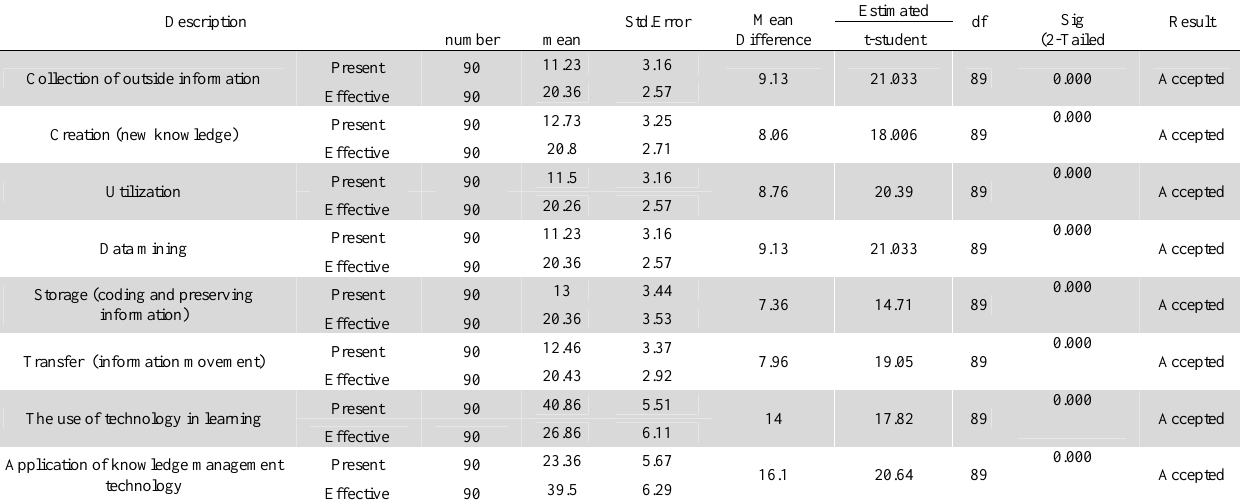
Evaluate significant difference between present and effective situation of knowledge and